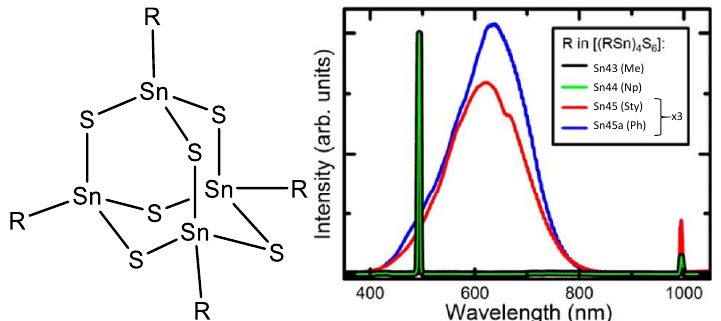
Figure 48. Chalcogenides reported by Dehnen et al. (Adapted with permission from [82], Rosemann,